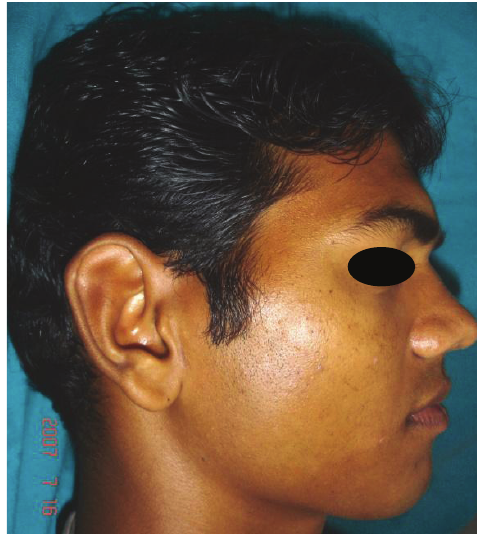
Figure 2: Pre-op right lateral view.